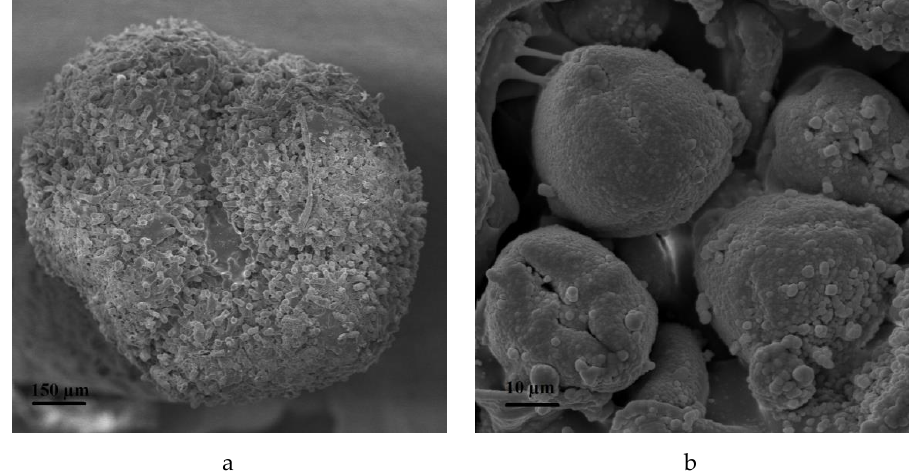
Figure 2. Stigma in eggplant pistil with visible papillae in a receptive phase, ( a ), and pollen grains ( b ) in “ Epic ” F 1 by scanning electron microscopy.